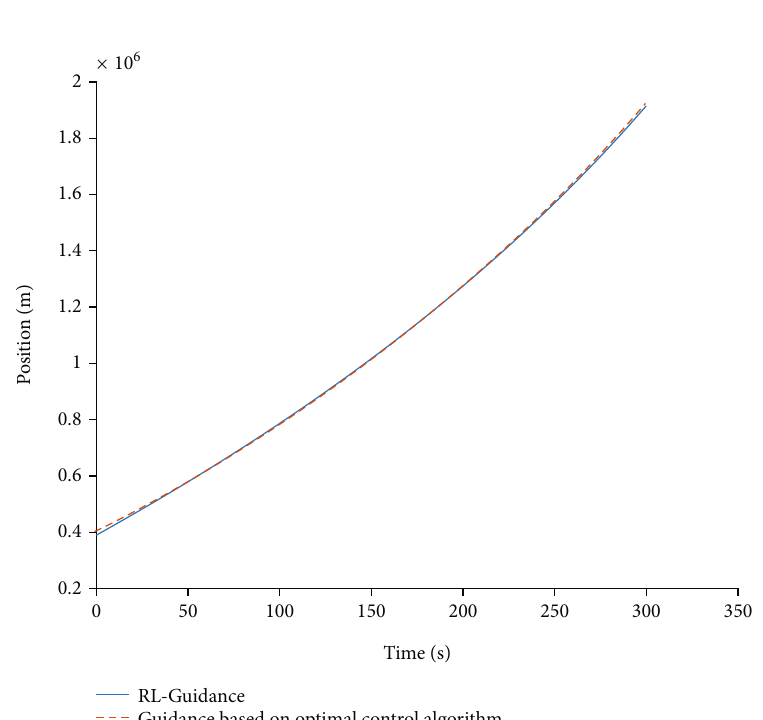
Figure 5: Learning curves of reward.